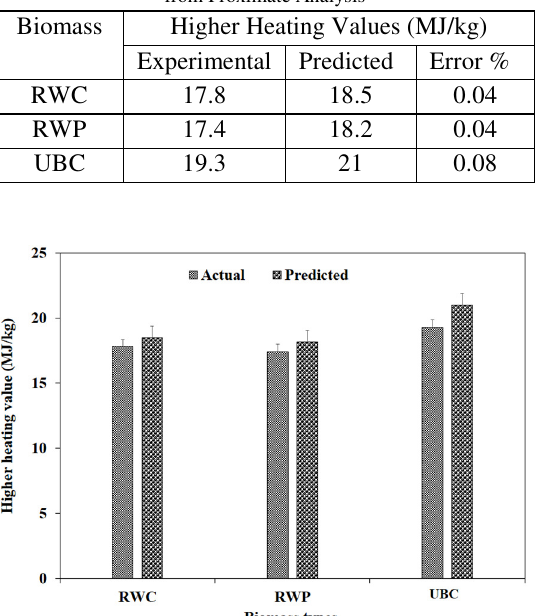
Table 2: Comparison of HHV between Measured and Estimates